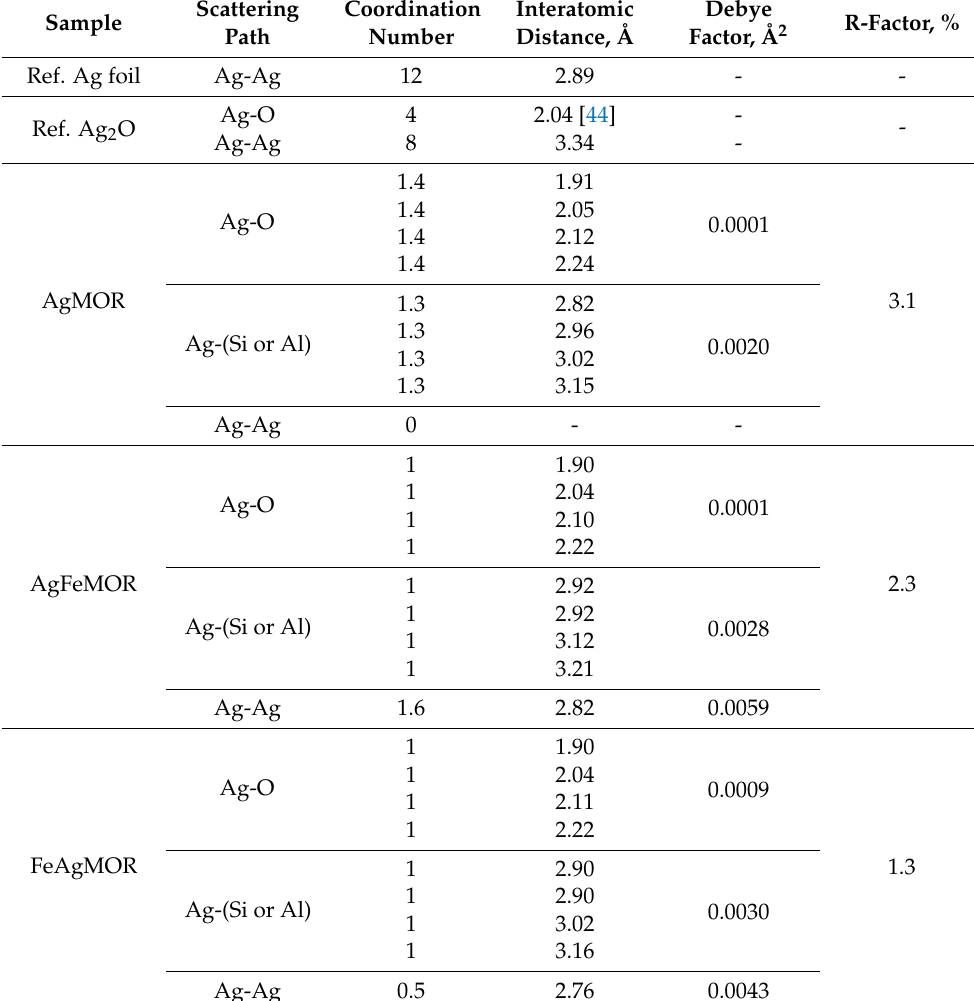
Table 4. Structural parameters obtained from Ag K-edge EXAFS fitting (R-range is from 1.2 to 3 Å, k-range is from 3 to 15 Å − 1 , kw = 3) for references and studied samples. Scattering Coordination Interatomic Debye R-Factor, % Sample Path Number Distance, Å Factor, Å 2 Ref. Ag